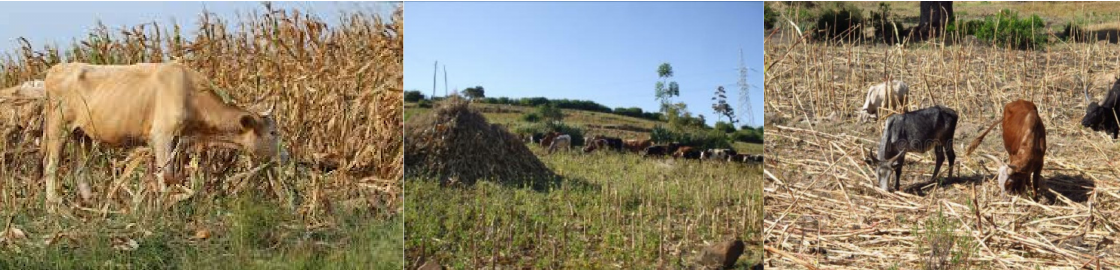
Figure 4. Aftermath grazing in Ethiopia (https://www.google.com/search, accessed on 2 October